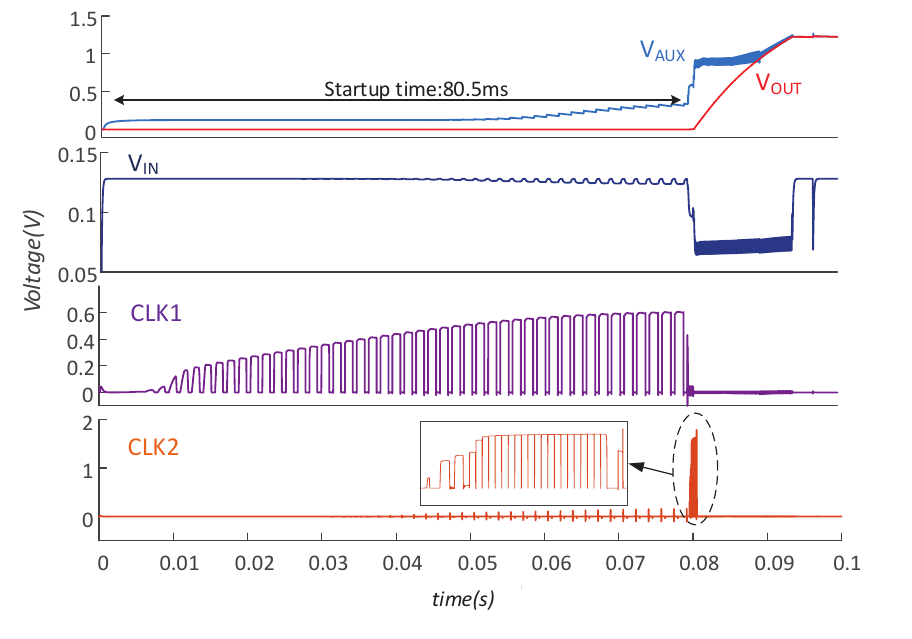
Figure 12. The waveform of startup process.